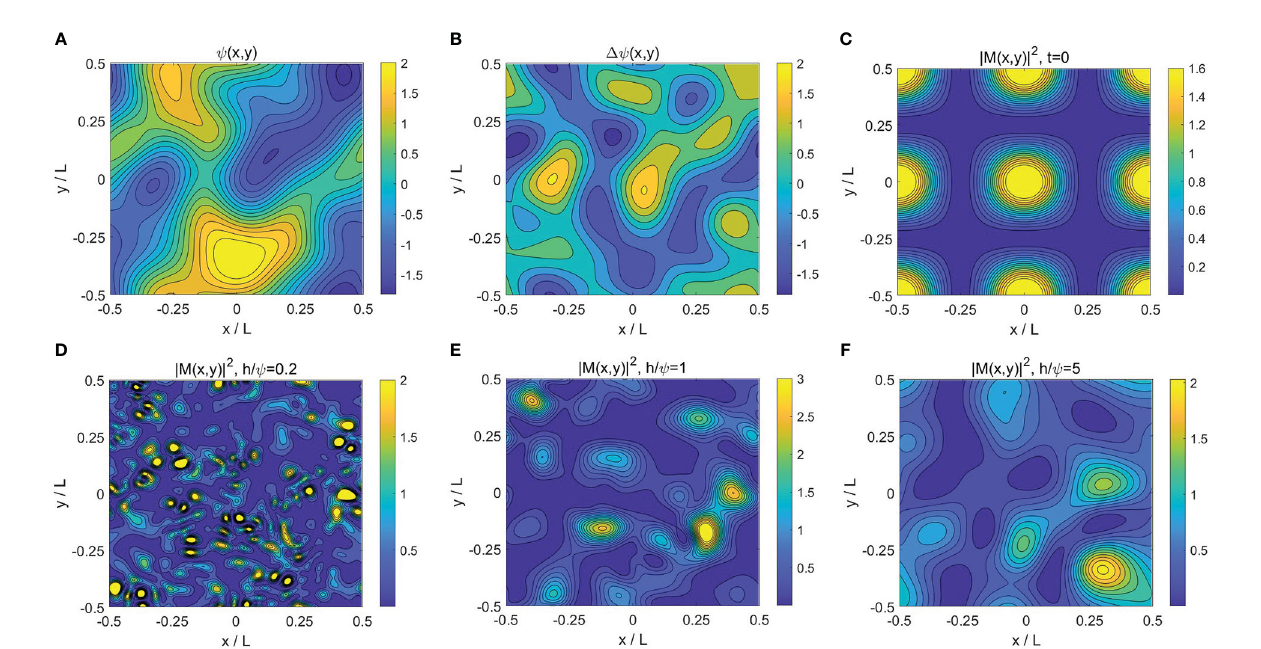
FIGURE 11 (A, B) Density plots of the random stream function (A) and associated vorticity fi eld (B) with h / Y =1. (C) The initial condition for the velocity fi eld, as set in Eq.(28) with n=1. (D – F) The long-time evolutionary behaviors of NIWs with different h / Y =0.2,1,5, respectively. The domain size is L =4 p